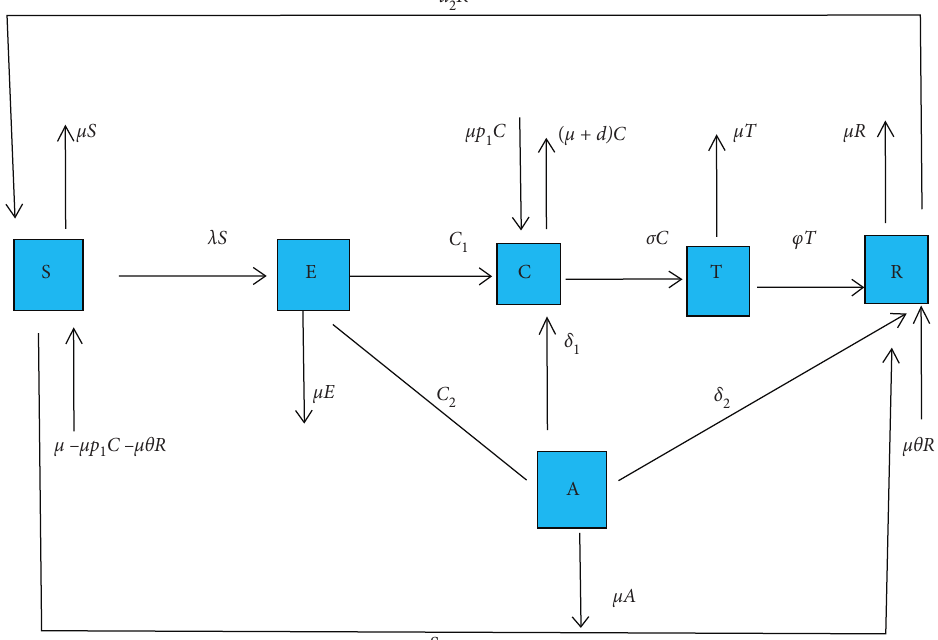
Figure 1: Corresponding flow diagram of SEACTR